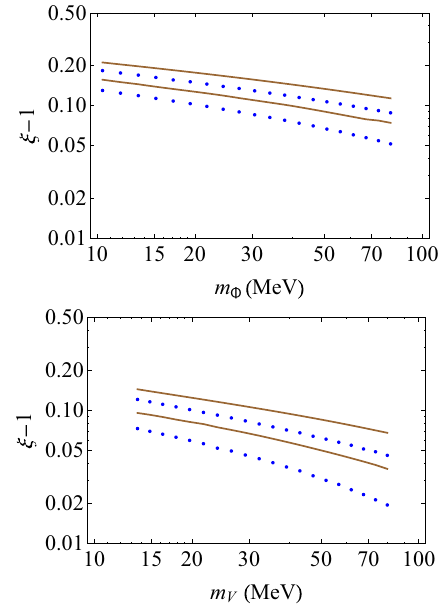
Fig. 1 The required value of ξ − 1 for scalar and vector millicharged (cid:4) = 10 − 4 DMwiththeEDGESobservation.Thecouplingparameter e D is taken here. The mass range of the scalar millicharged DM is 10 . 4 (cid:2) m φ (cid:2) 80 MeV, and 13 . 6 (cid:2) m V (cid:2) 80 MeV for vector millicharged DM. The dotted, solid curves are for the case of e D = 1, 0.5, respec- tively. In each type of curve (dotted, solid curves), the upper (lower) one corresponds to f DM = 0 . 02 (0.003), respectively experiment, the corresponding ξ required is shown in Fig. 1 (cid:4) = 10 − 4 for (see Appendix for the calculation), with e D scalar and vector millicharged DM. The dotted (solid) curves = 1 (0.5) being adopted, respectively, are for the value e D and the upper (lower) one in each type of curve corresponds (cid:4) 2 , a to f DM = 0 . 02 (0.003), respectively. For a given e 2 D smaller fraction f DM corresponds to a smaller ξ − 1 value.